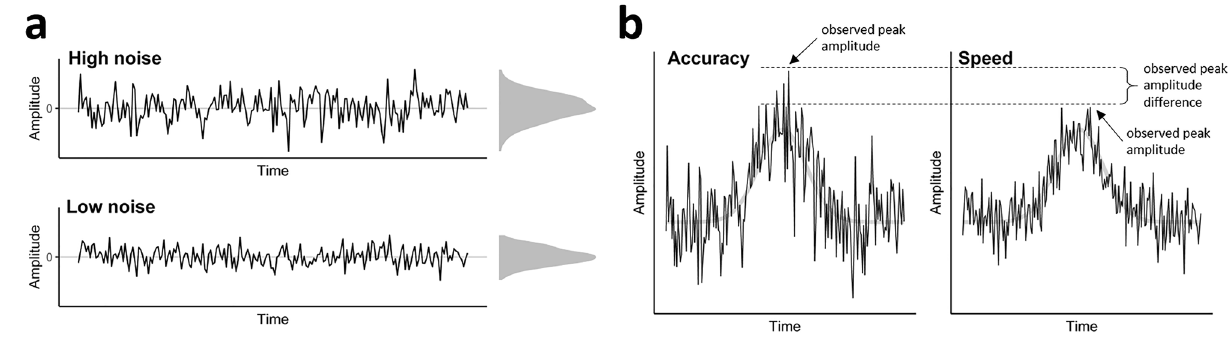
(light grey), the peak is higher when noise is high than when noise is low.